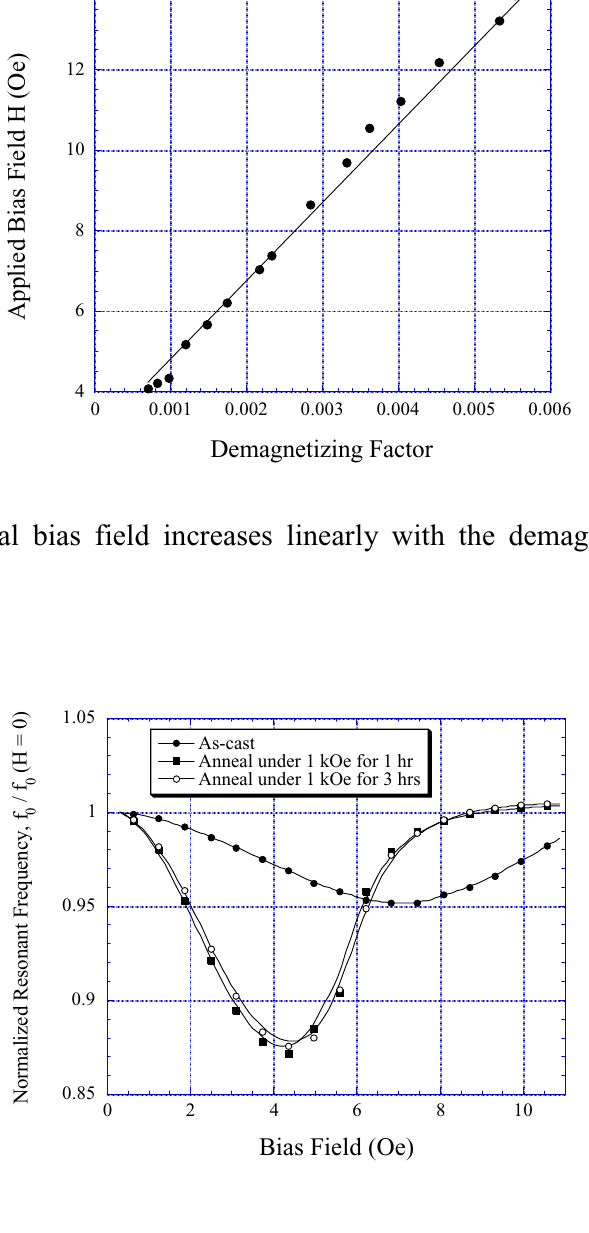
Figure 20. Transverse-field annealing of the magnetoelastic sensor increases the ∆ E effect and decreases the anisotropy field H k